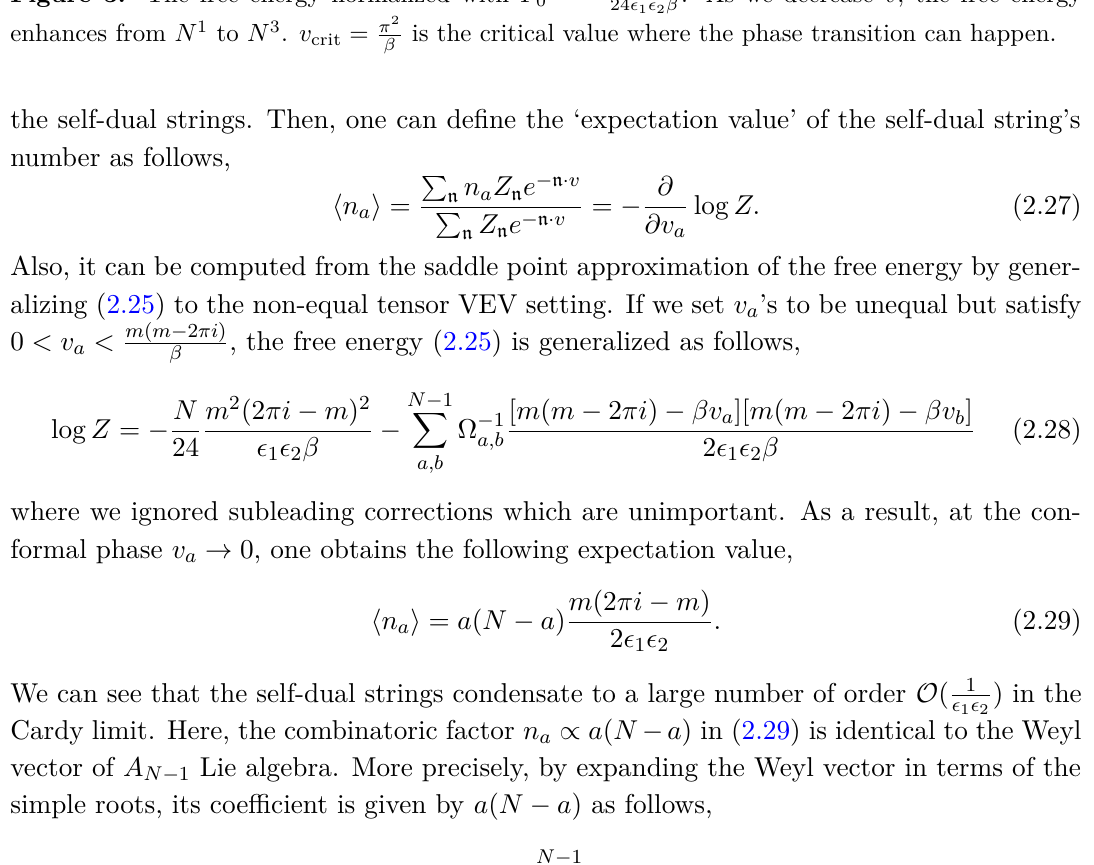
Figure 3. The free energy normalized with F 0 = − π 4 enhances from N 1 to N 3 . v crit = π 2